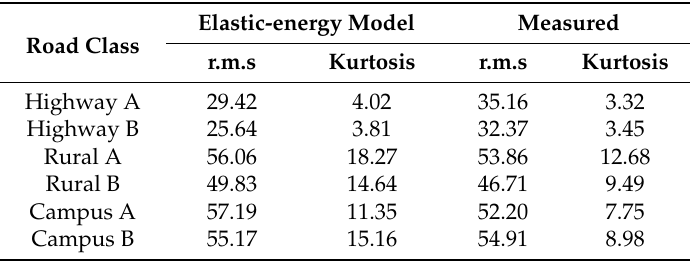
Table 3. Predicted Coffin-Manson fatigue lives using measured and elastic-energy model converted strain.